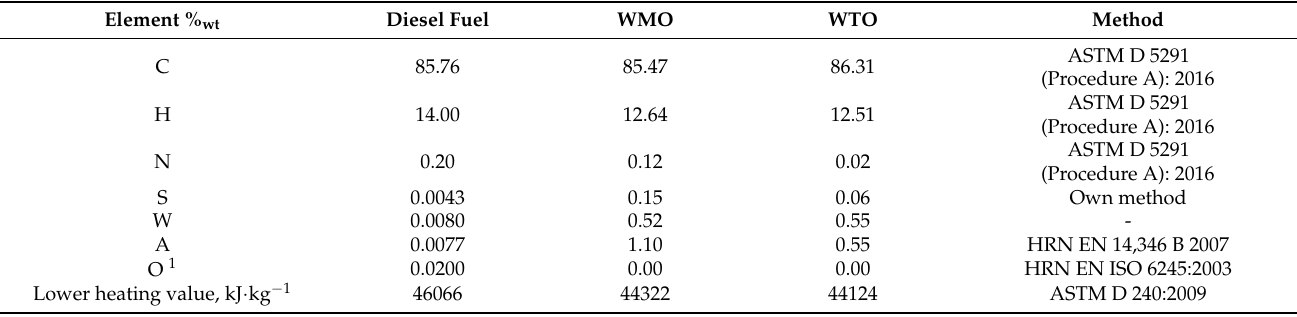
Table 1. Chemical properties of diesel fuel